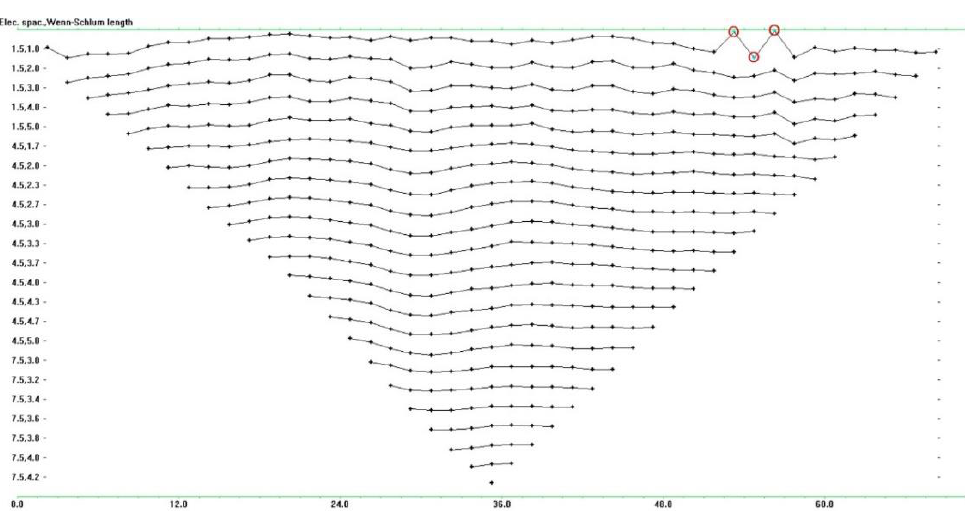
Figure 11. The distribution of bad data points (red circles) for the survey performed with the Dipole– Dipole array.